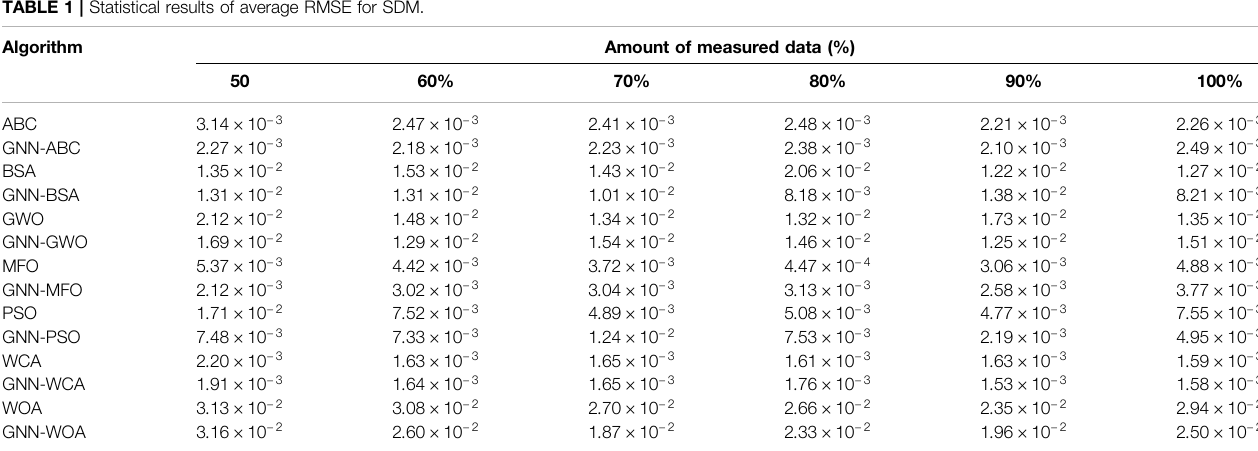
TABLE 1 | Statistical results of average RMSE for